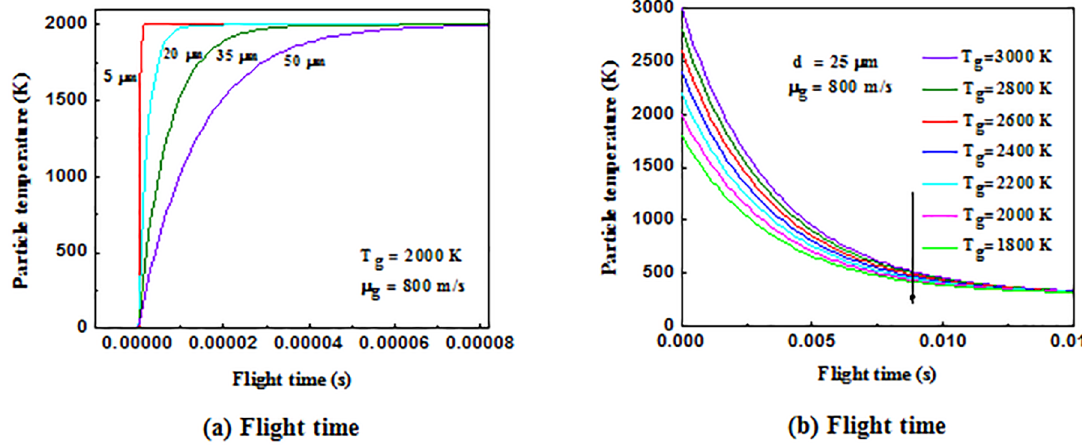
Figure 2. Relationships between the particle temperature and flight time (a) and